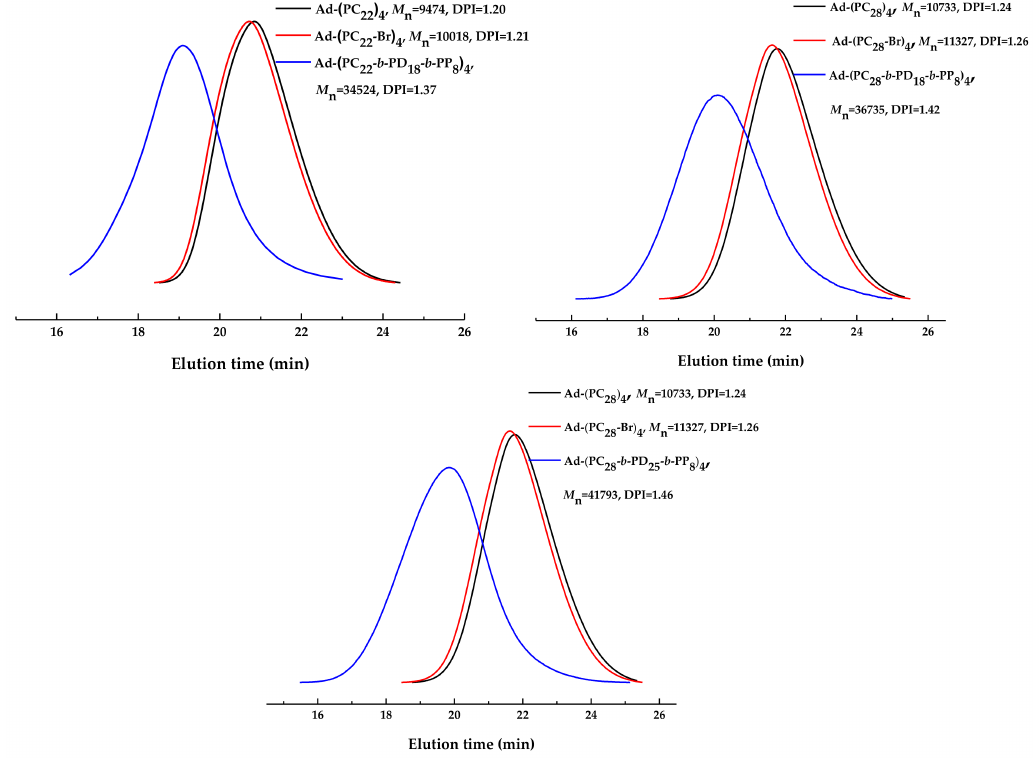
Figure 2. GPC traces of Ad-(PC 22 - b -PD 18 - b -PP 8 ) 4 , Ad-(PC 28 - b -PD 18 - b -PP 8 ) 4 , Ad-(PC 28 - b -PD 25 - b -PP 8 ) 4 and their